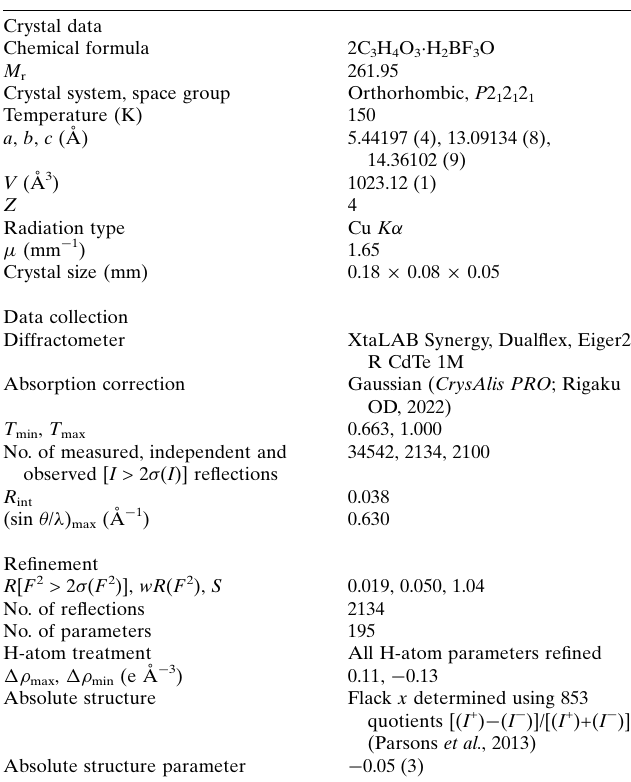
Table 2 Experimental